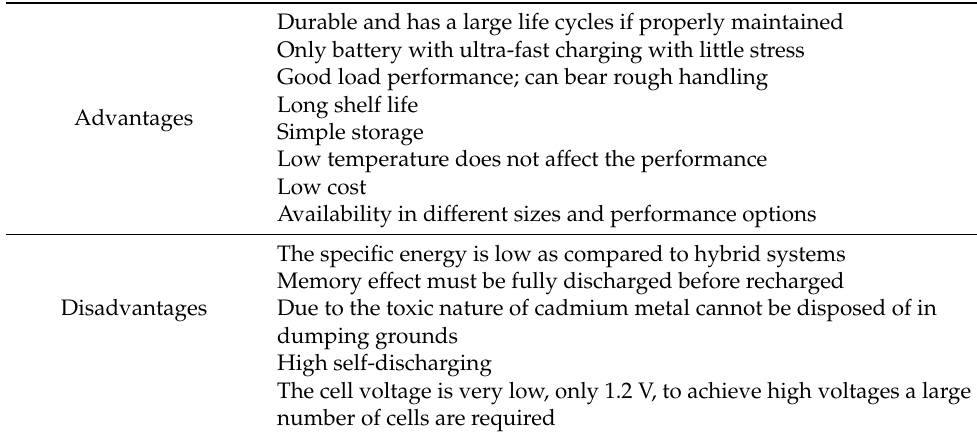
Table 2. Advantages and limitations of Ni–Cd batteries. Durable and has a large life cycles if properly maintained Only battery with ultra-fast charging with little stress Good load performance; can bear rough handling Long shelf life Advantages Simple storage Low temperature does not affect the performance Low cost Availability in different sizes and performance options The specific energy is low as compared to hybrid systems Memory effect must be fully discharged before recharged Disadvantages Due to the toxic nature of cadmium metal cannot be disposed of in dumping grounds High self-discharging The cell voltage is very low, only 1.2 V, to achieve high voltages a large number of cells are